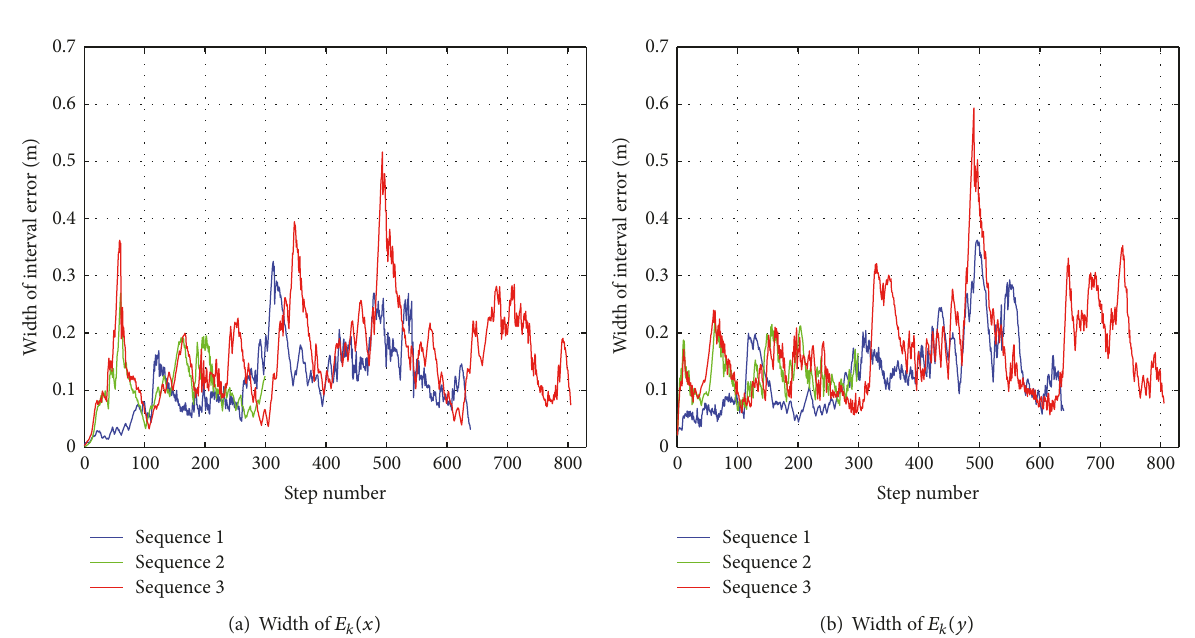
Figure 19: Interval error width of localization result.